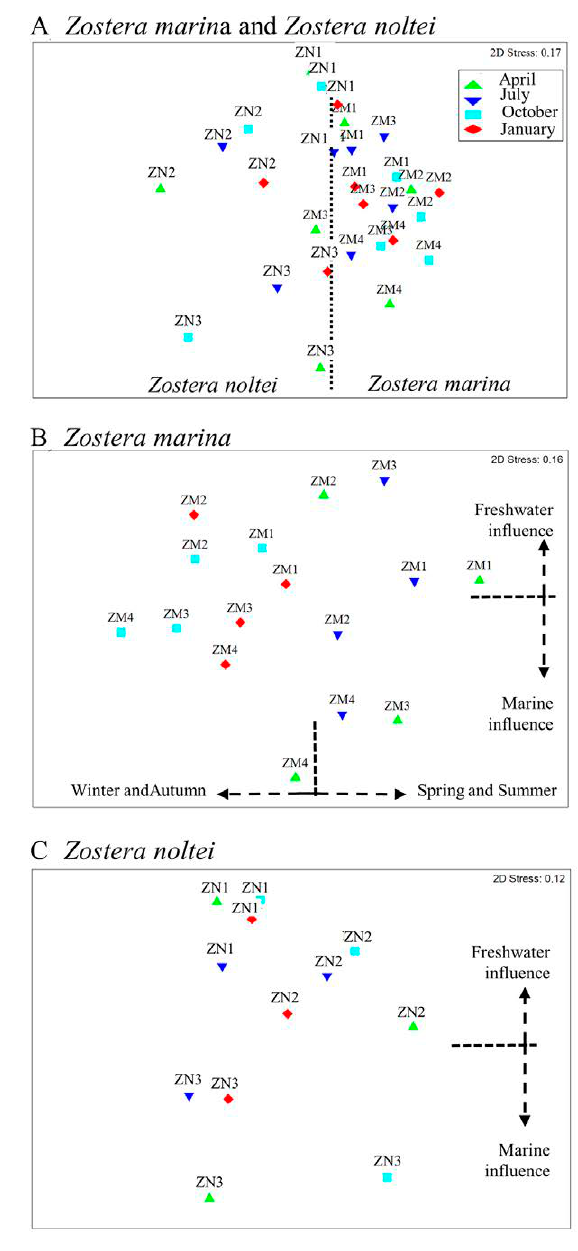
Fig. 6. – Multidimensional scaling analysis ordination of the sam- pling sites showing month groups: Zostera marina and Zostera noltei beds (A); Zostera marina bed (ZM1-ZM4) (B); and Zostera noltei bed (ZN1-ZN3) (C). Dashed lines indicate the spatial (marine and freshwater influence) and the seasonal gradients (winter and autumn, spring and summer) in the